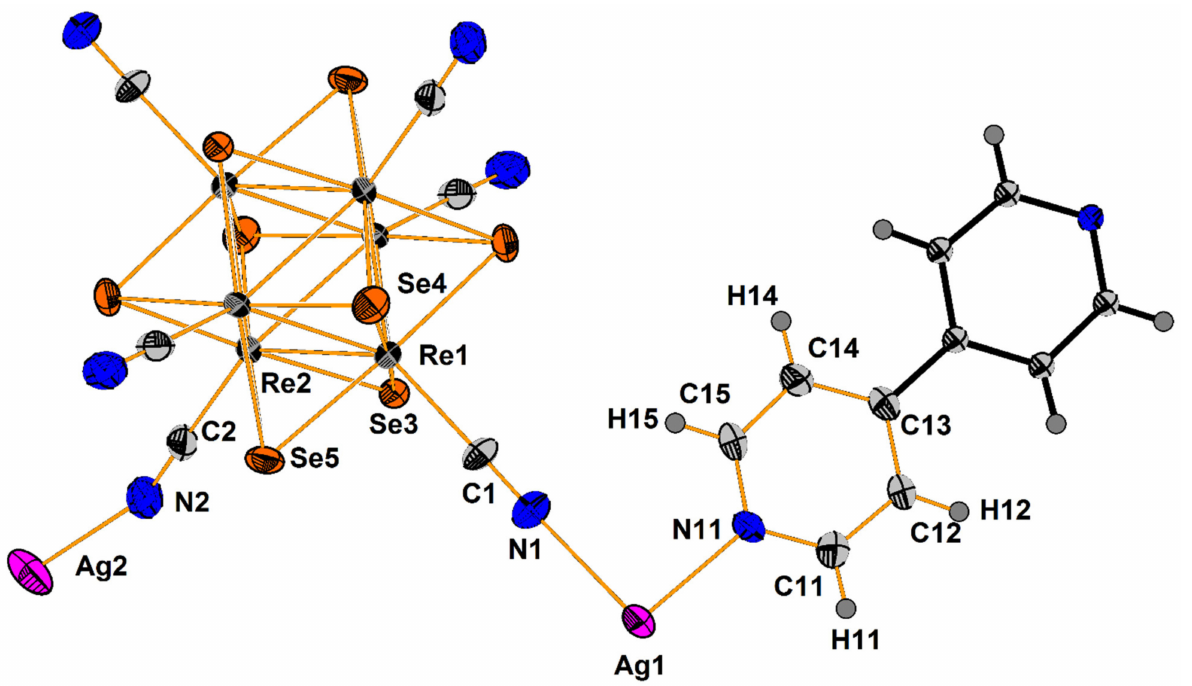
Figure 11. ORTEP drawing of the asymmetric unit in the structure of 4 . Thermal ellipsoids of 75% probability.